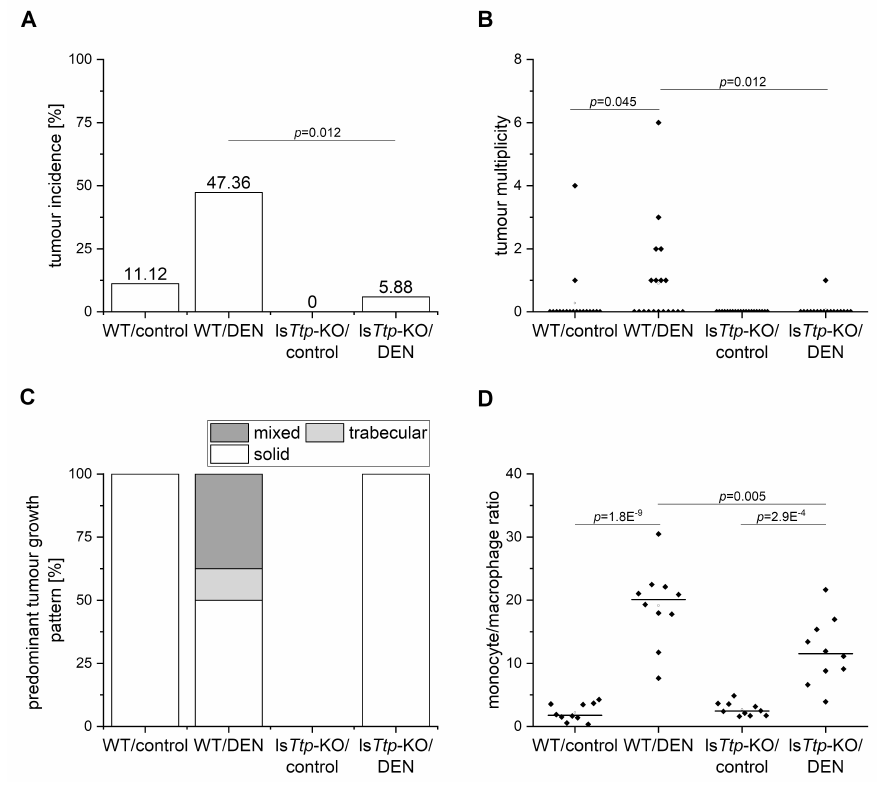
Figure 1. Amount and pattern of tumors and hepatic monocyte to macrophage ratio in diethylnitrosamine (DEN)- or sham-treated wild type (WT) and tristetraprolin (TTP)-knockout (ls Ttp -KO) mice. ( A ): Tumor incidence. ( B ): Tumor multiplicity. ( C ): Predominant tumor growth pattern. ( D ): Monocyte / macrophage ratio analyzed by multi-color flow cytometry (short-term experiment). n = 10, each.